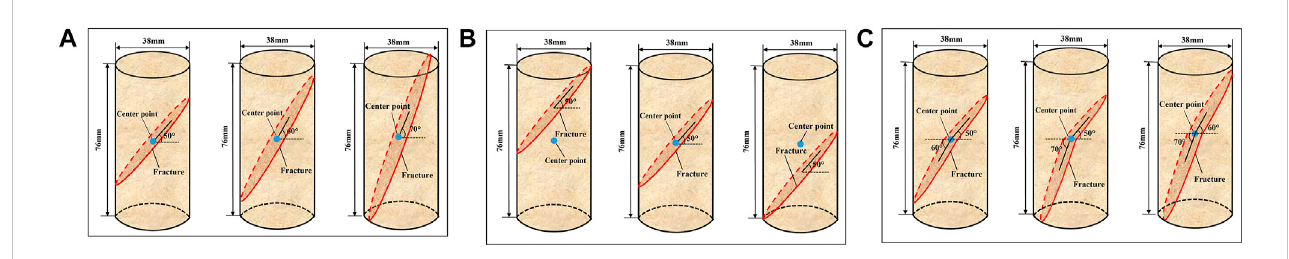
FIGURE 2 Fracture distribution patterns: (A) Different fractured angle; (B) Different fractured position; (C) Different composite